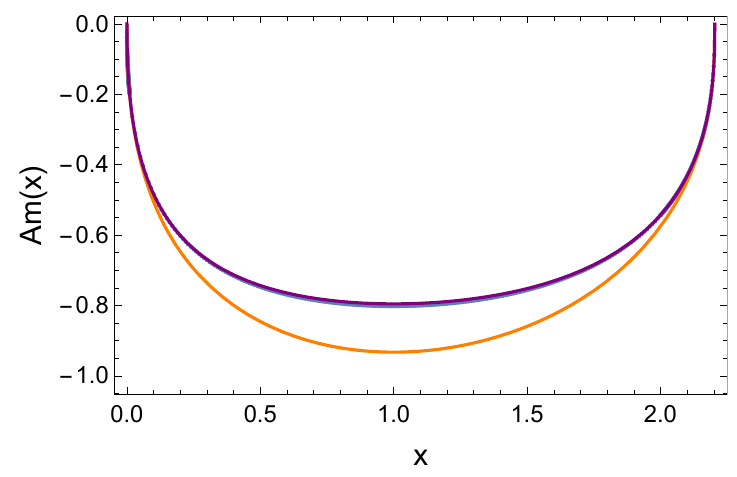
Figure 7 . Ambiguity function at NLL. The blue points represent numerical results of the integral in eq. (3.18). The ambiguity function corresponding to the u = 1 = 2 renormalon is shown by the orange line, and the sum of the u = 1 = 2 and 3 = 2 ones is shown by the purple line, which almost coincides with the blue points. We take n f =